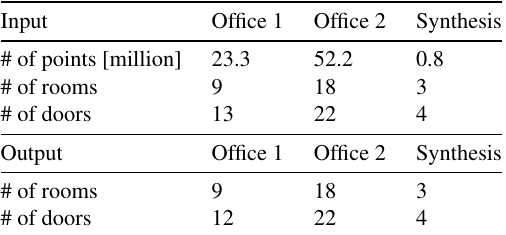
Table 1. Description of the input data and statistics of the outputs